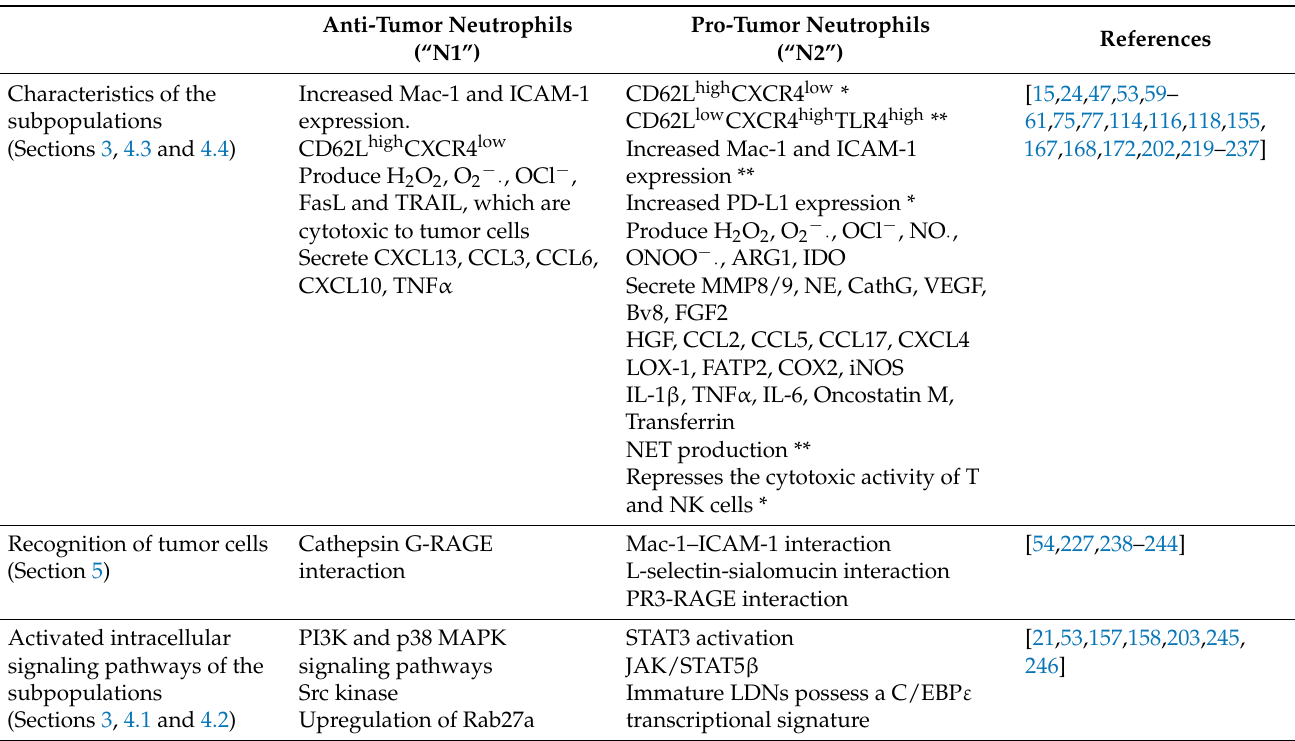
(Table 3). Co-stimulation of neutrophils with IL-6 and G-CSF increased phospho-STAT3 levels, resulting in the upregulation of the pro-angiogenic MMP9 and Bv8 and downregulation of TRAIL